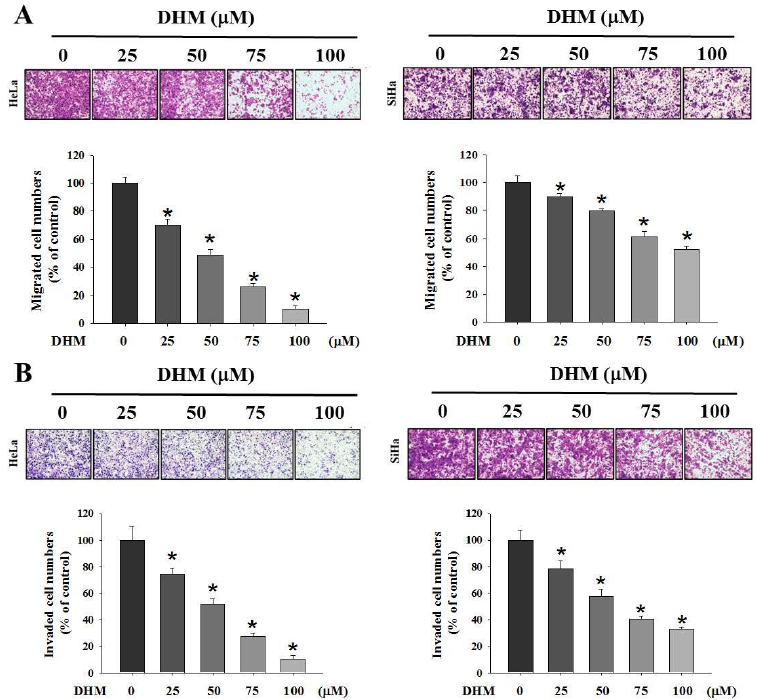
Figure 2. Effects of DHM on cell migration and invasion in cervical cancer cell lines. ( A , B ) HeLa and SiHa cells were seeded onto a 6 cm dish and treated with DHM (0, 25, 50, 75, 100 µ M) for 24 h. Analyzed by Boyden chamber assay. The values represented the mean ± S.D. from three determinations per condition repeated three times. *, p < 0.05 compared with untreated. Cells were photographed using microscope (100 ×